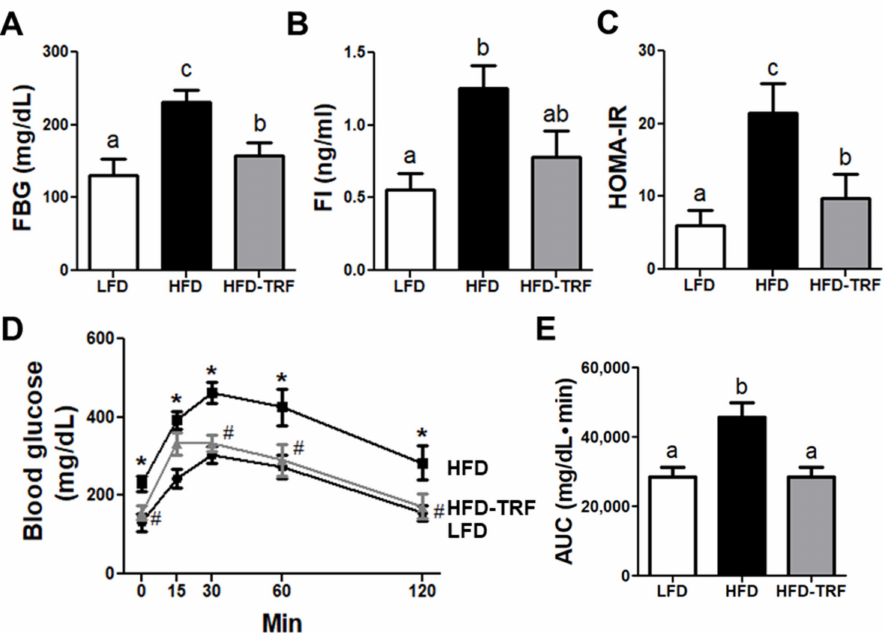
Figure 6. Effects of time-restricted feeding (TRF) on HOMA-IR and glucose tolerance. C57BL/6 mice were fed with a low-fat diet ad libitum (LFD), high-fat diet ad libitum (HFD), high-fat diet ad libitum followed by time-restricted feeding (HFD-TRF) for 12 weeks. ( A ) Fasting blood glucose; ( B ) fasting insulin; ( C ) insulin resistance index (HOMA-IR), measured as FBG (mmol/L) × FI (mU/L)/22.5. ( D , E ) Glucose and area of glucose under the curve (AUC) during glucose tolerance test upon i.p. injection of 1.2g glucose/kg body weight. Data are presented as mean ± SEM ( n = 7). a,b,c Different superscripts indicate significant difference at least at p < 0.05 by ANOVA with Tukey’s post hoc test. HFD (vs. LFD), * p < 0.05; HFD-TRF (vs. HFD), # p <